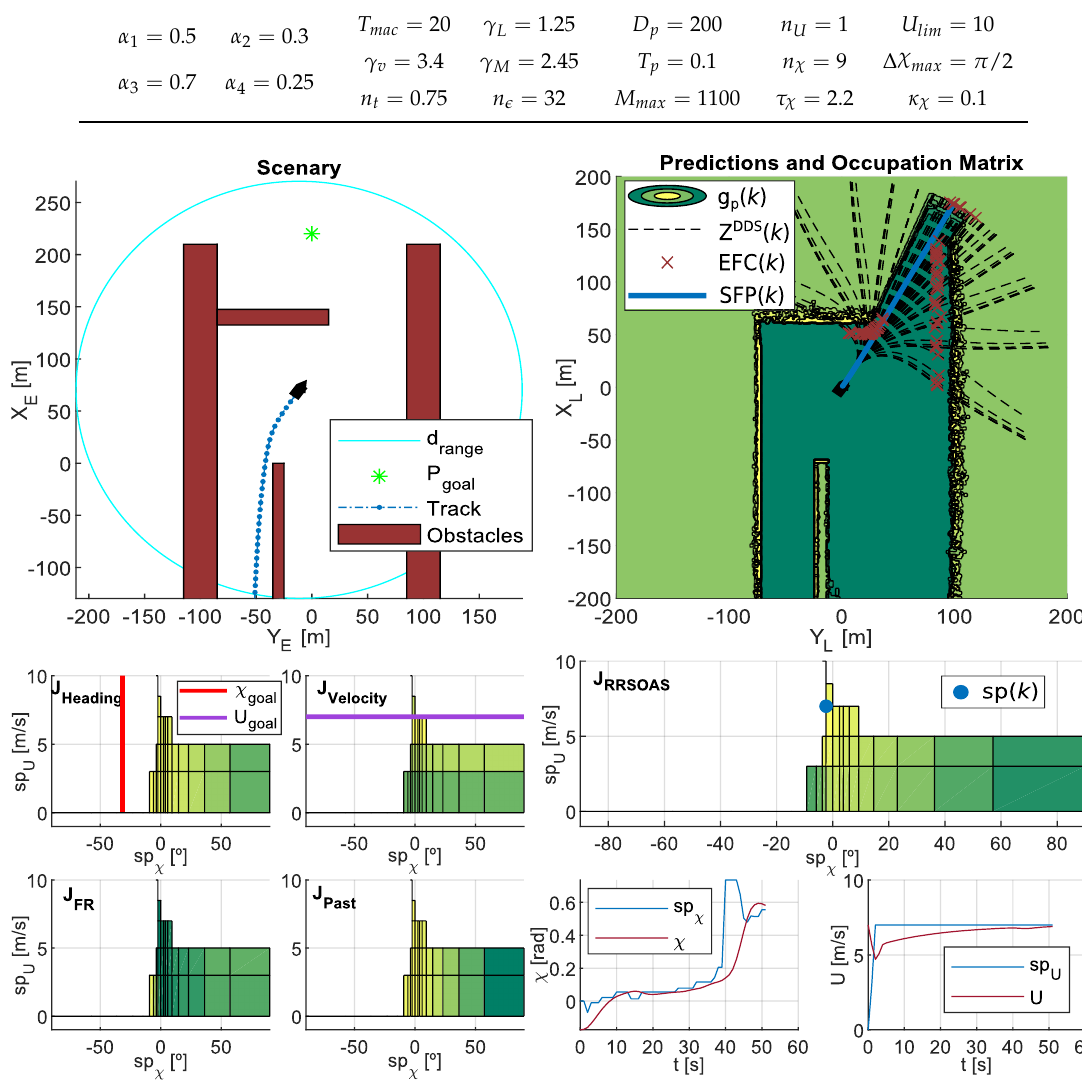
Figure 11. A RRSOAS execution period: evolution of the course/velocity setpoints, USV path, translation of the predictions to the occupancy probability grid (estimated future collisions (EFC) and selected future path (SFP)) and Heuristics